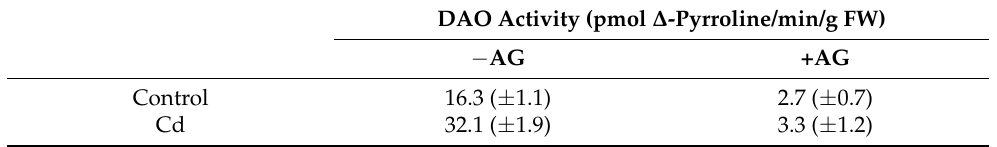
Table 1. Inhibition of DAO activity by AG. DAO activity was measured in the control plants (control, − AG) or in plants treated for 3 days with aminoguanidyne added to the nutrient solution before the collection (control, +AG) as well as in plants, which after 3 days of treatment with Cd were transferred to the control conditions without (Cd, − AG) or with aminoguanidyne (Cd, +AG) for another 3 days.